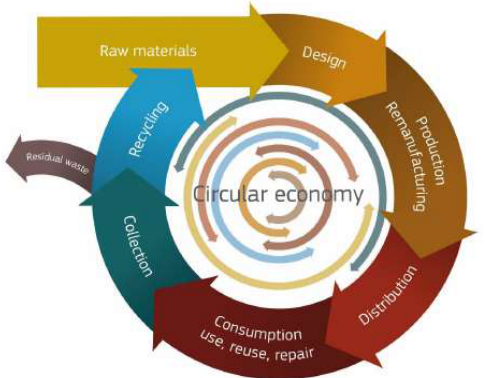
Figure 1. Conceptional diagram illustrating a CE in a simplified manner [12].